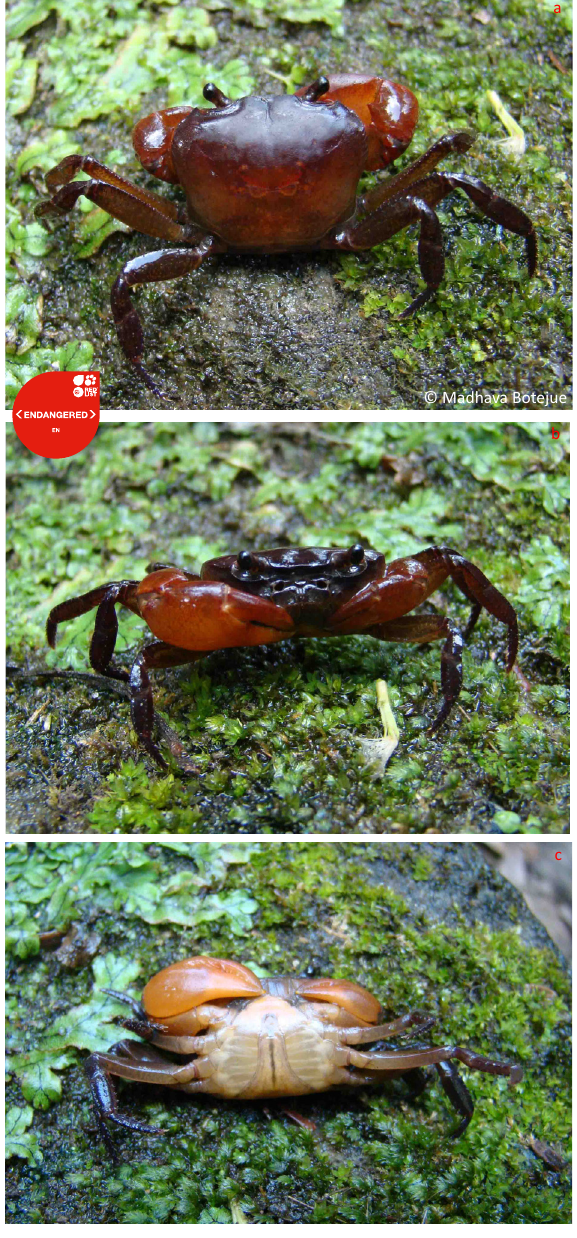
Image 2. Ceylonthelphusa armata living male from the type locality, 18.1mm carapace width and 14.2mm carapace length. a - dorsal view; b - ventral view; c - frontal